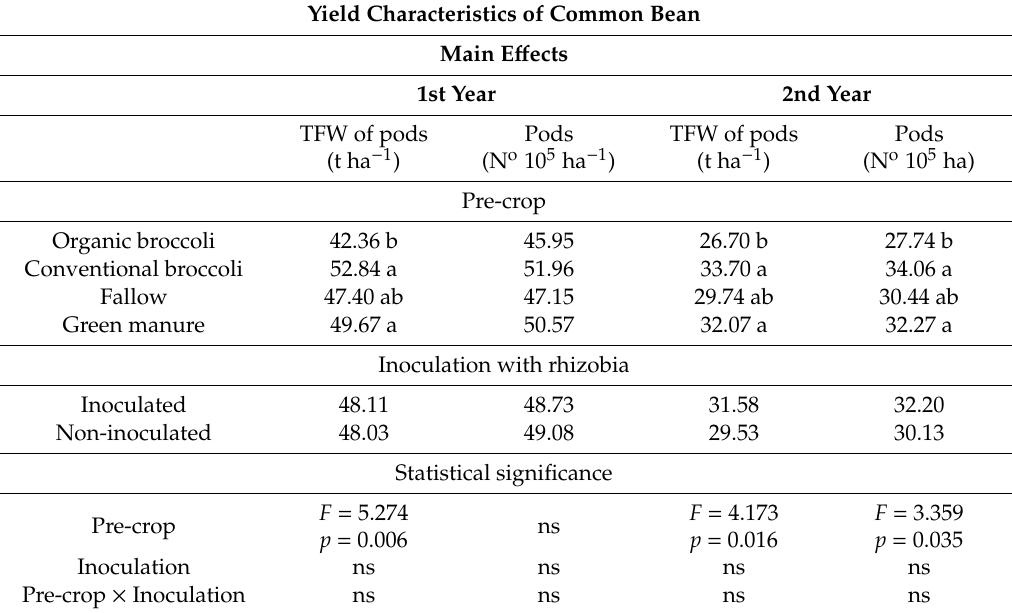
Table 4. Impact of di ff erent pre-crop treatments during the wintertime and inoculation of the common bean with Rhizobium tropici CIAT 899 on total fresh weight (TFW) and number (No) of pods per plant in a summer open-field crop of the common bean during two successive experimental